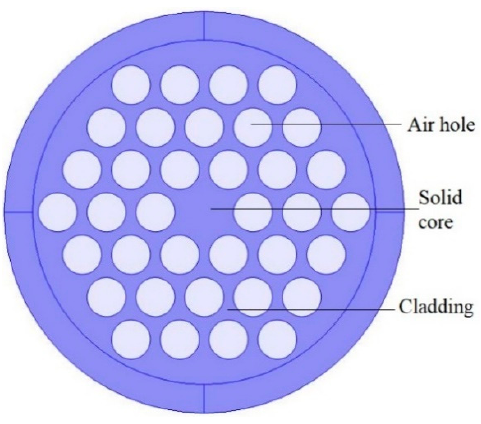
Figure 2. Diagram of solid core PCF.